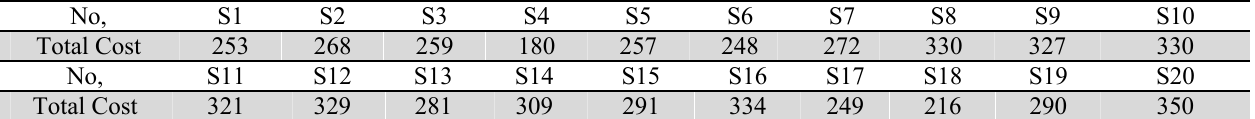
The total cost of each